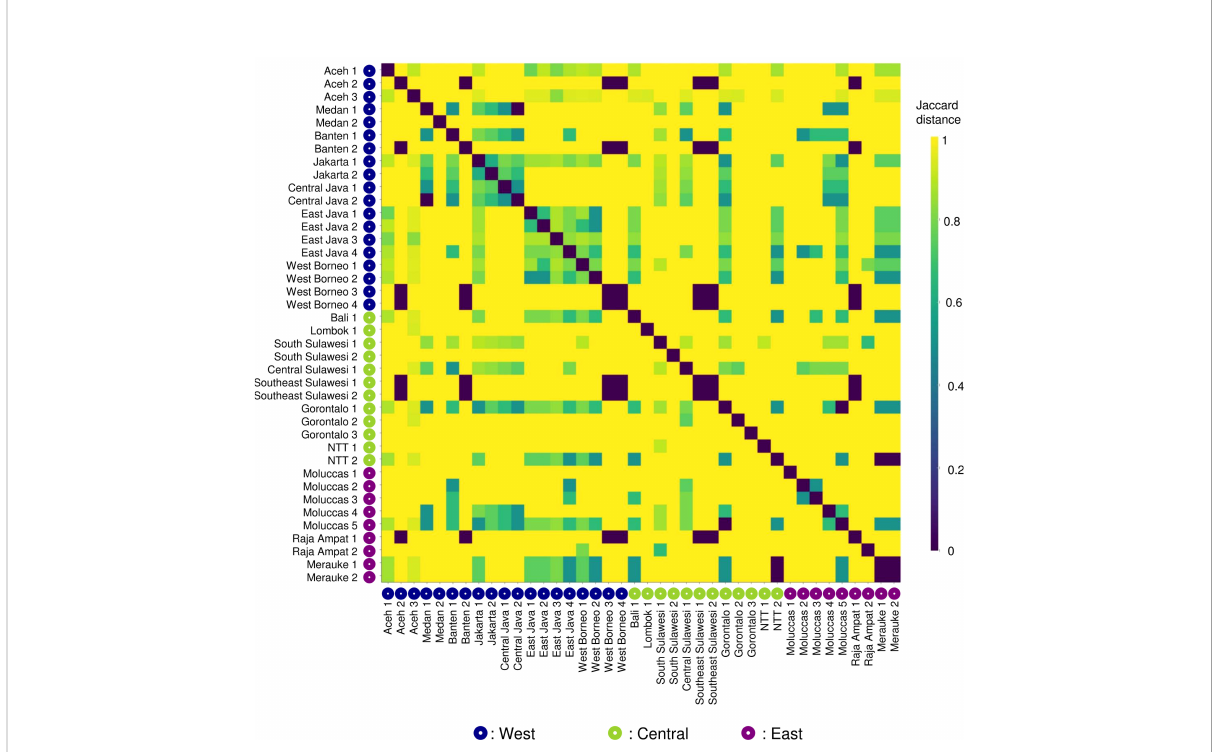
FIGURE 7 Heatmap analysis of beta diversity calculated as Jaccard distances and examined using ANOSIM analysis reported a non-signi fi cant difference in species occurrences between regions (R = 0.01115, p = 0.308) but signi fi cant between province differences (R = 0.16915, p =